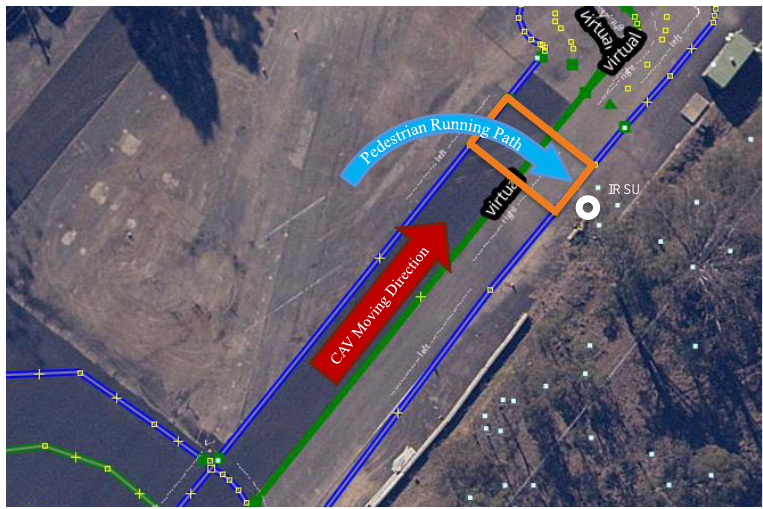
Figure 20. Experiment setup in a lab environment. It is shown in the Lanelet2 map and lidar feature map built for the experiment site, which contains the road boundaries and lanes information. The light blue dots distributed in the bottom right corner represent the locations of observed features in the environment (trees, poles, corners of structures). The designated pedestrian crossing area is labelled as an orange